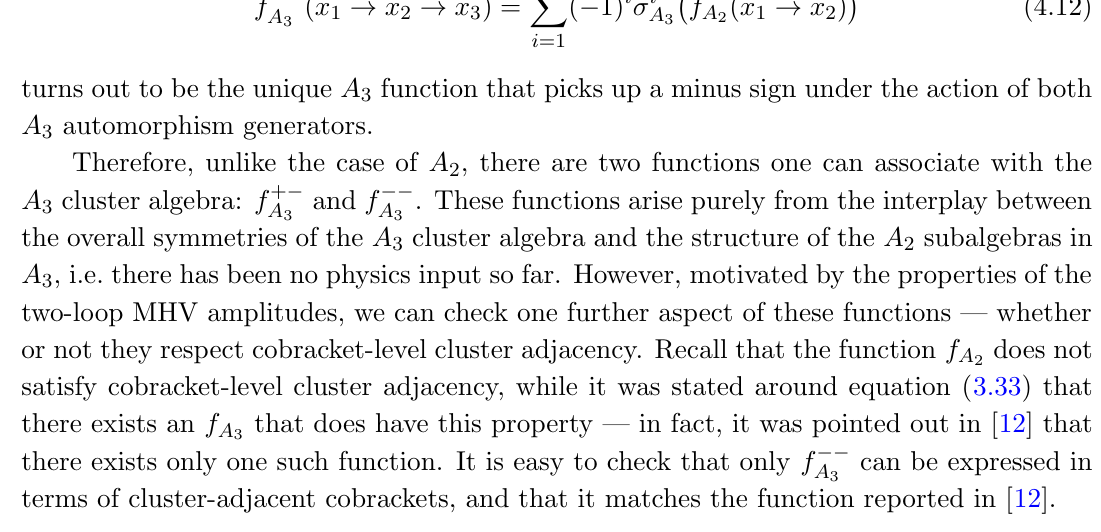
Table 1. The number of nonclassical weight-four cluster polylogarithms on the A n (cid:20) algebra, for each of the four possible automorphism signatures. The number of functions that additionally respect cobracket-level cluster adjacency is given in